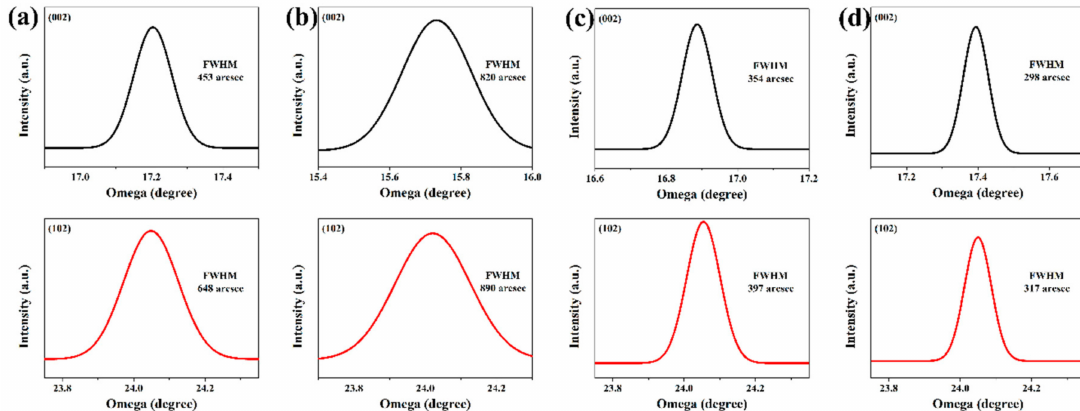
Figure 5. High-resolution X-ray di ff raction (HRXRD) rocking curves of (002) and (102) of HVPE grown GaN crystals: S1 ( a ), S2 ( b ), S3 ( c ), S4 ( d ).